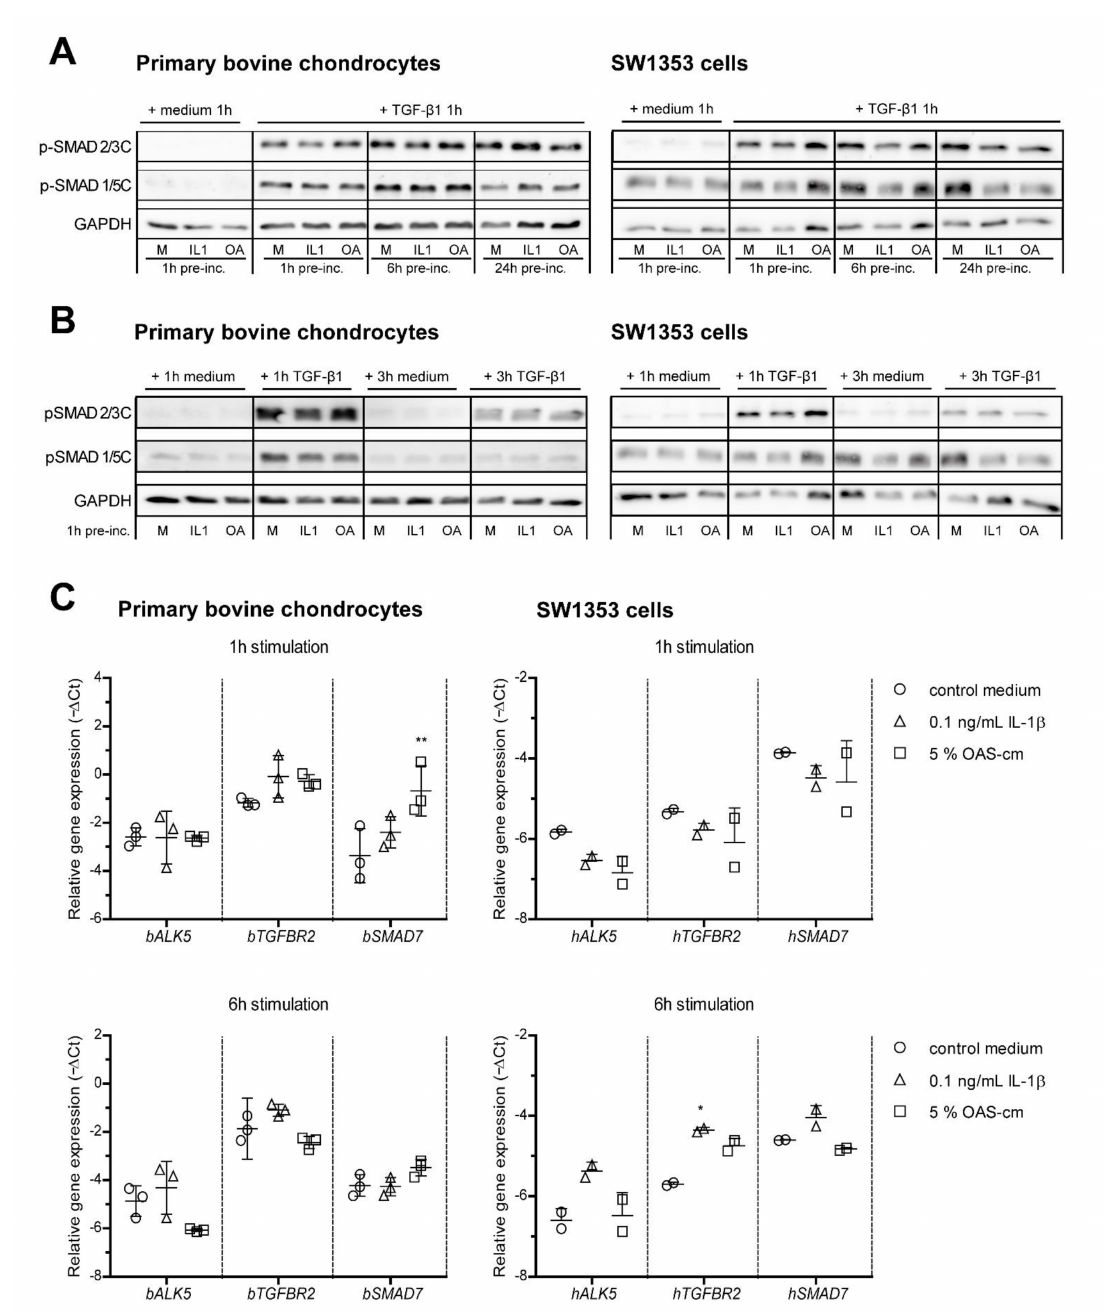
Figure 3. IL-1 β and OAS-cm do not alter C-terminal phosphorylation of SMAD transcription factors and do not regulate receptor level expression. In search of an explanation for the inhibition of OA-related inflammatory factors on functional TGF- β signaling, we investigated if IL-1 β and OAS-cm influence C-terminal SMAD2/3 and SMAD1/5 phosphorylation in bovine chondrocytes cultured in monolayer and in SW1353 chondrosarcoma cells using Western blot ( A , B ). Pre-incubation for different time periods (1, 6 and 24 h) with 0.1 ng/mL IL-1 β (IL1) or 2.5% OAS-cm (OA) did not alter p-SMADC activation with 1 ng/mL TGF- β ( A ) and also signal duration was not affected ( B ). GAPDH was included as loading control. ( C ) Relative gene expression of TGF- β receptors ALK5 and TGFBR2 and inhibitory SMAD7 in bovine chondrocytes and SW1353 cells 1 h and 6 h after stimulation with medium supplemented with 0.1 ng/mL IL-1 β or 5% OAS-cm. Data are plotted as mean ± SD with each dot representing the average of 2 replicates of 4 explants in one cow ( n = 3), or in case of the SW1353 cells of two independent experiments performed in duplicate. Statistical analysis was performed using a one-way ANOVA with Bonferroni’s post hoc test: * p ≤ 0.05; ** p ≤